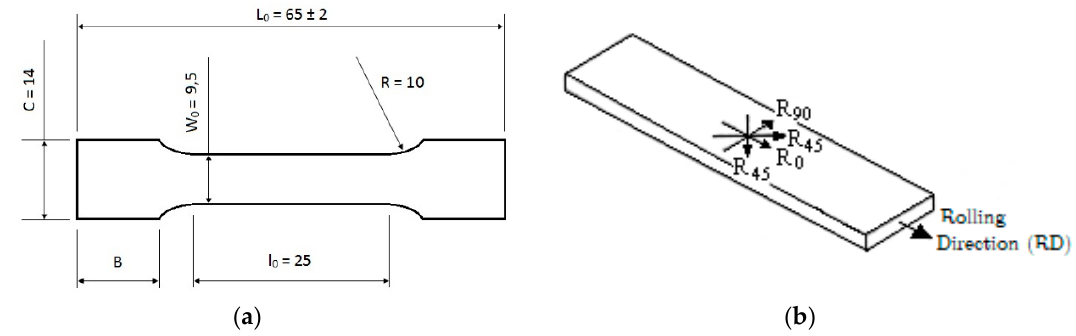
Figure 3. ( a ) Illustration of the small pre-loaded samples, axially cut in angles of 0°, 45°, and 90° relative to the rolling direction [mm]; ( b ) loading and cutting orientations relative to the rolling direction.